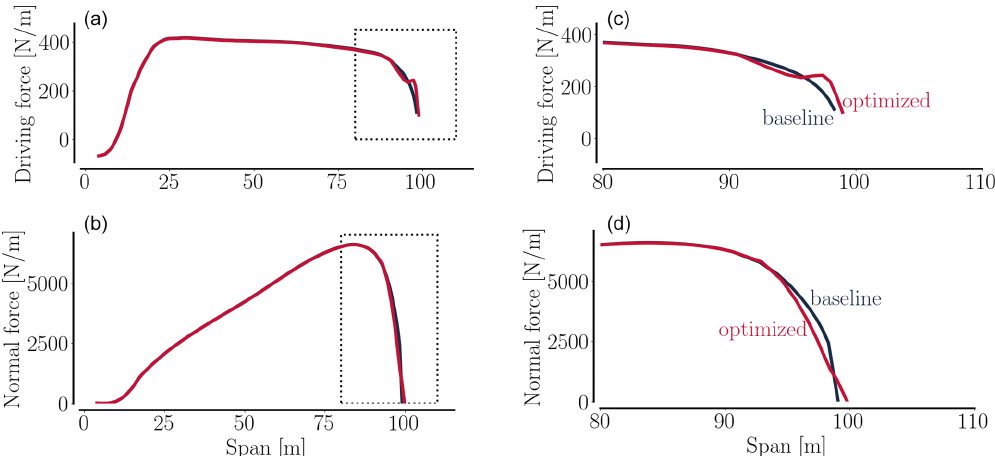
Figure 14. Driving (a, c) and normal (b, d) forces for the shape optimization result from grid level L1. Dashed black rectangles (a, b) indicate limits for the zoomed-in plots (c, d) .